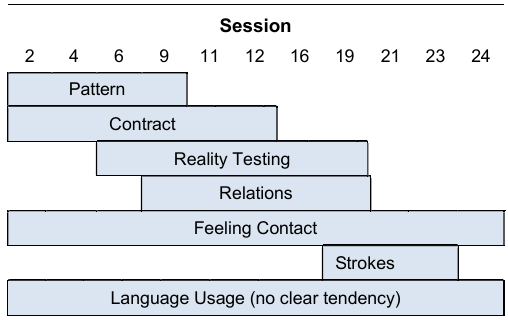
Table 6: The most frequent codings of the different main categories during different phases of therapy